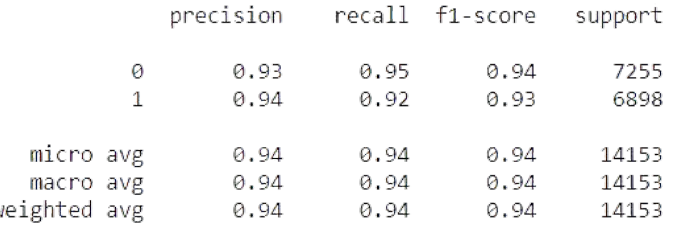
Figure 28. LSTM metrics.